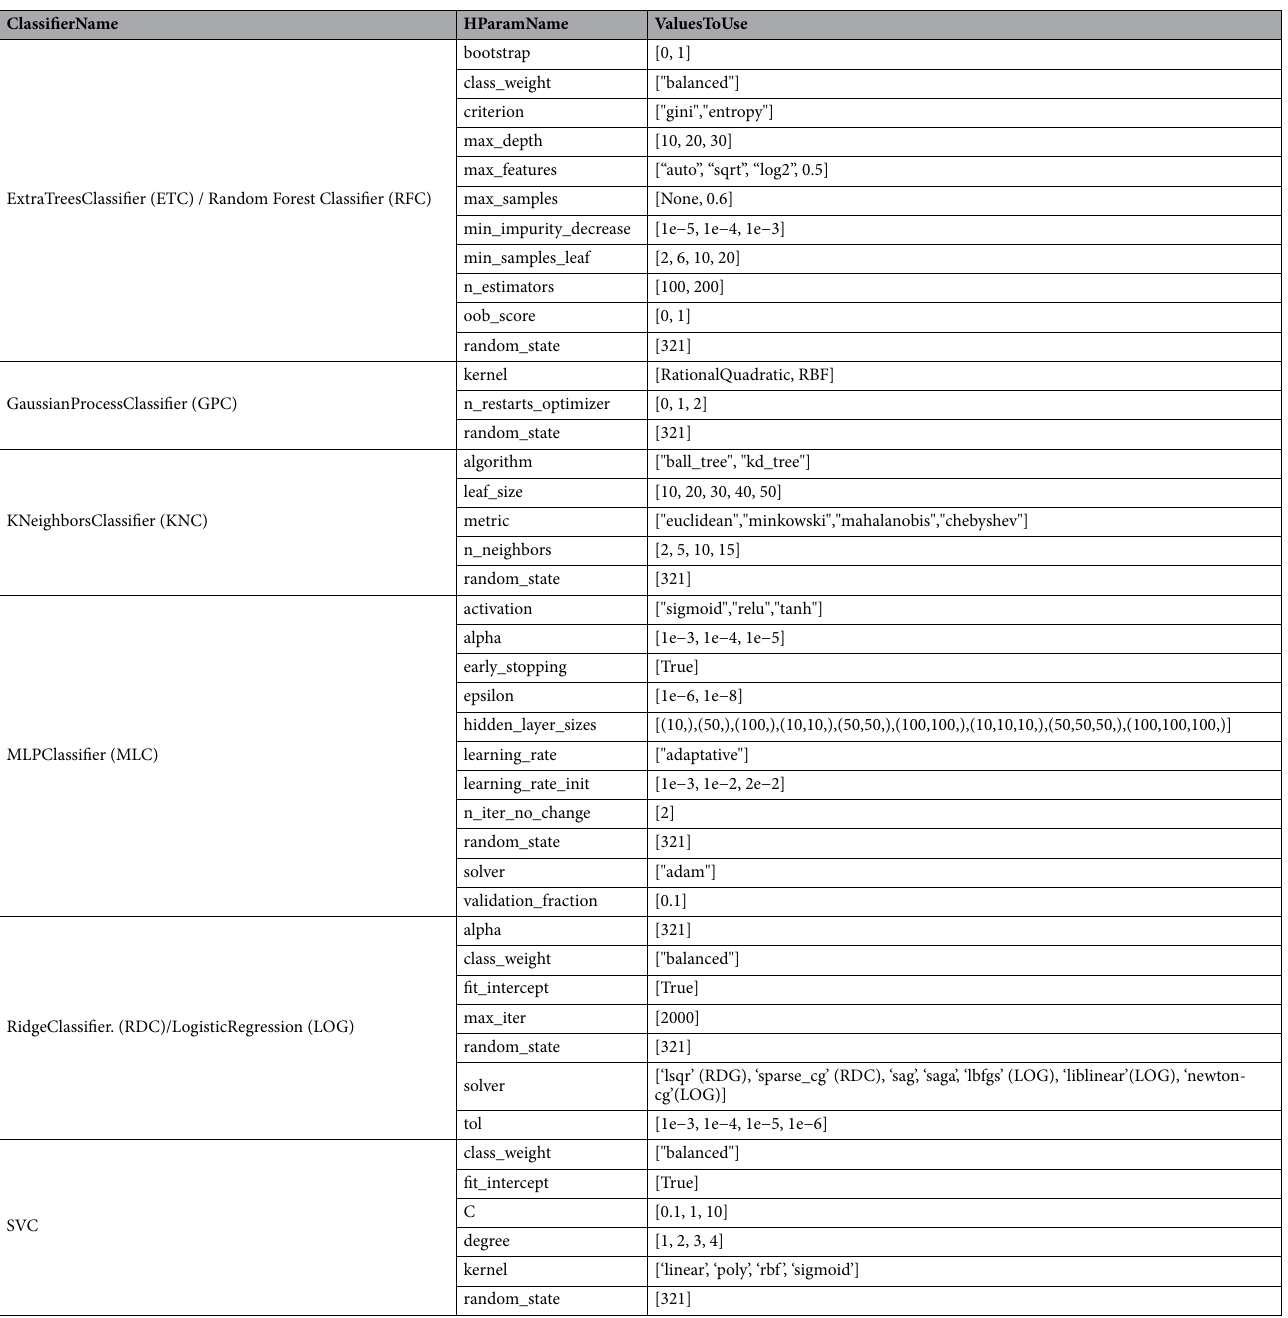
Table 7. Hyper-parameters for model selection. Hyper-parameters used during the model selection for Table 3. ClassifierName column contains the name of the classifier and our acronym. Some classifiers were grouped since they have similar hyper-parameters like ExtraTreesClassifier (ETC) and Random Forest Classifier (RFC); and RidgeClassifier (RDC) and LogisticRegression (LOG). HParamName contains the names of the hyper-parameter names in the same format as sklearn version 0.24.2 (stable). ValuesToUse column contains the list of potential values of those hyper-parameters to be evaluated. Some values are specific for only one classifier and therefore have the acronym for the model in parenthesis (e.g. ‘lsqr’ (RDC) and ‘lbfgs’ (LOG)). random_state and class_weight hyper-parameters were intended to have the same value across all models. The validation_fraction was used in MLPC to use the feature of early stopping : this created a sub-validation set under the training set different from the validation sets created for the